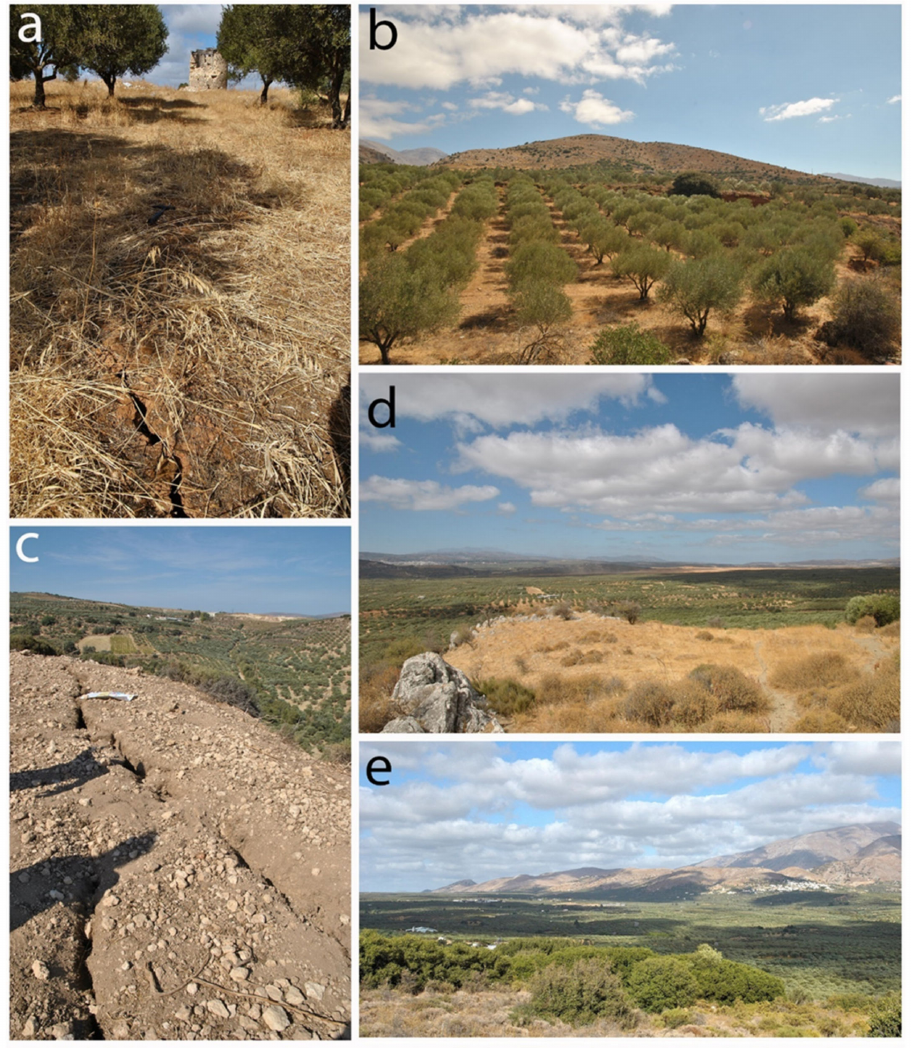
Figure 11. Field photographs ( a , c ) showing earthquake effects mapped by field surveys during the period September–November 2021 (by CF, AG, SV, IK) and panoramic views of the Kastelli Fault footwall ( b , e ) and hanging wall, respectively ( d ). The Nipiditos village is visible in ( e ). Elevation range 300–600